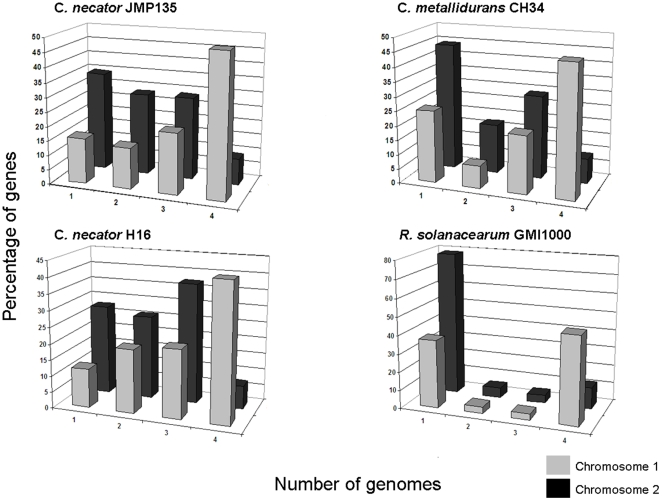
Distribution of shared and unique chromosomal genes in the genomes of three Cupriavidus and one Ralstonia.X-axis: the number of genomes (1–4) where the gene is found. Y-axis: the percentage of genes in the genome that are found in 1, 2, 3, or all 4 of the compared genomes.